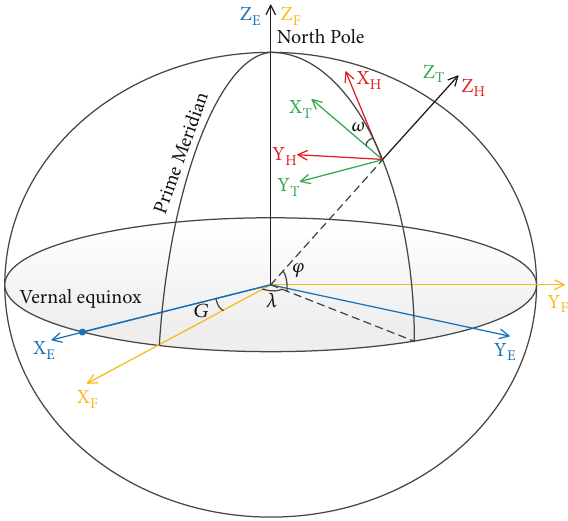
Figure 1: Space relation of the important